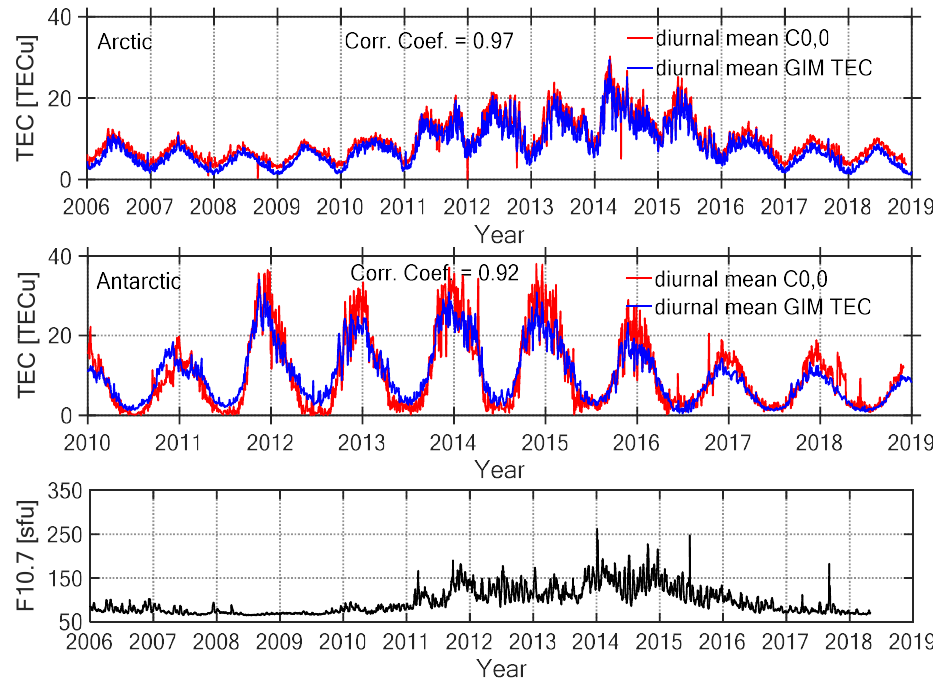
Figure 13. Mean diurnal variations of the C0,0 and the global ionospheric map (GIM) TEC in the Arctic ( top ), Antarctic ( middle ), and the time series of the solar activity index of F10.7 ( bottom ).